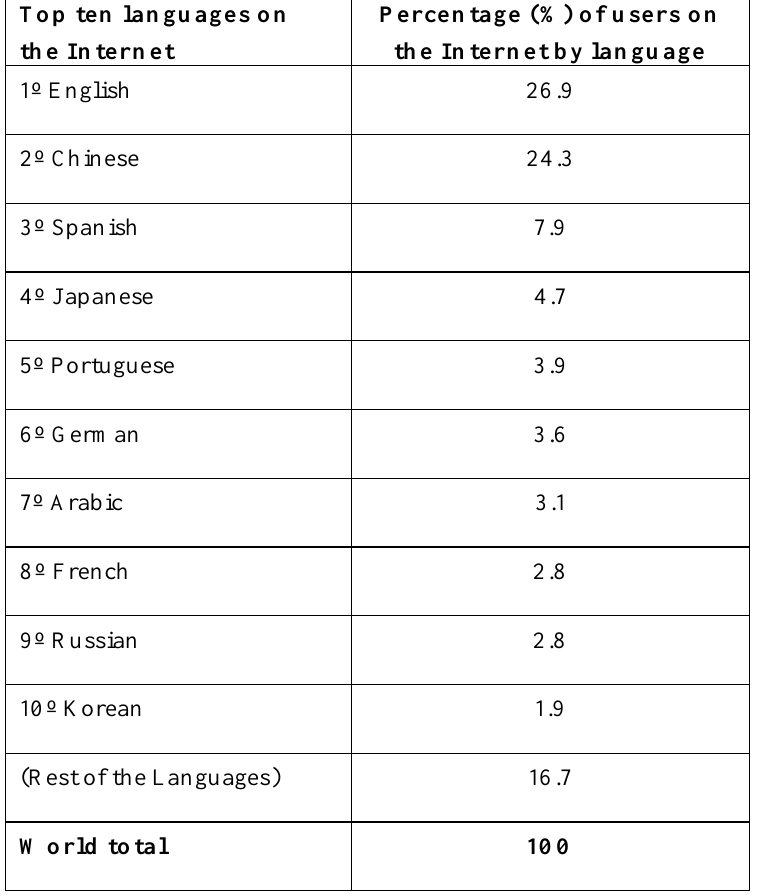
Table 2 Top Ten Languages Used on the Web Top ten languages